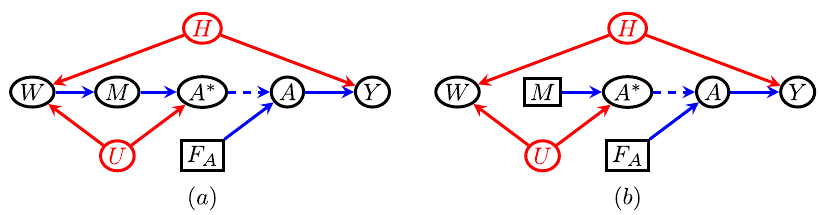
Figure 3: ( a ) The DT framework version of the napkin model. Only interventions on A are well - de fi ned. ( b ) A graph